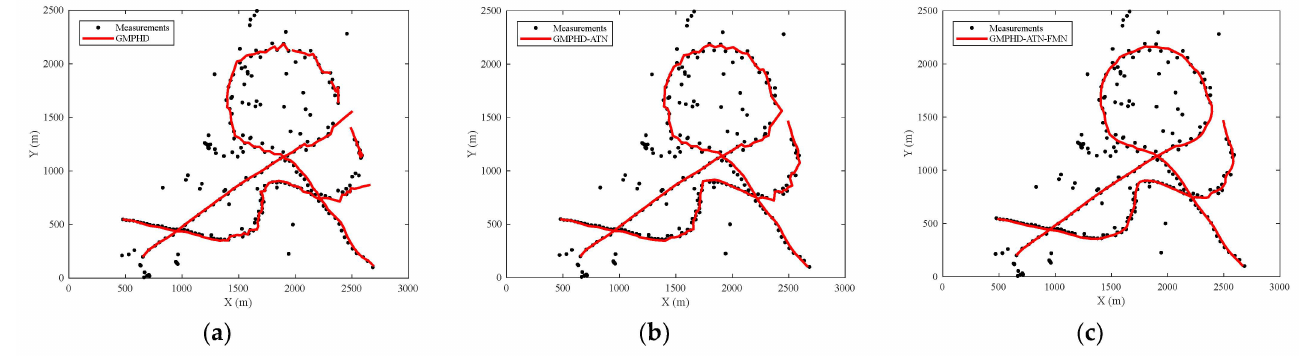
Figure 14. Comparisons of real UAV tracking results: ( a ) GMPHD, ( b ) GMPHD-ATN, and ( c )